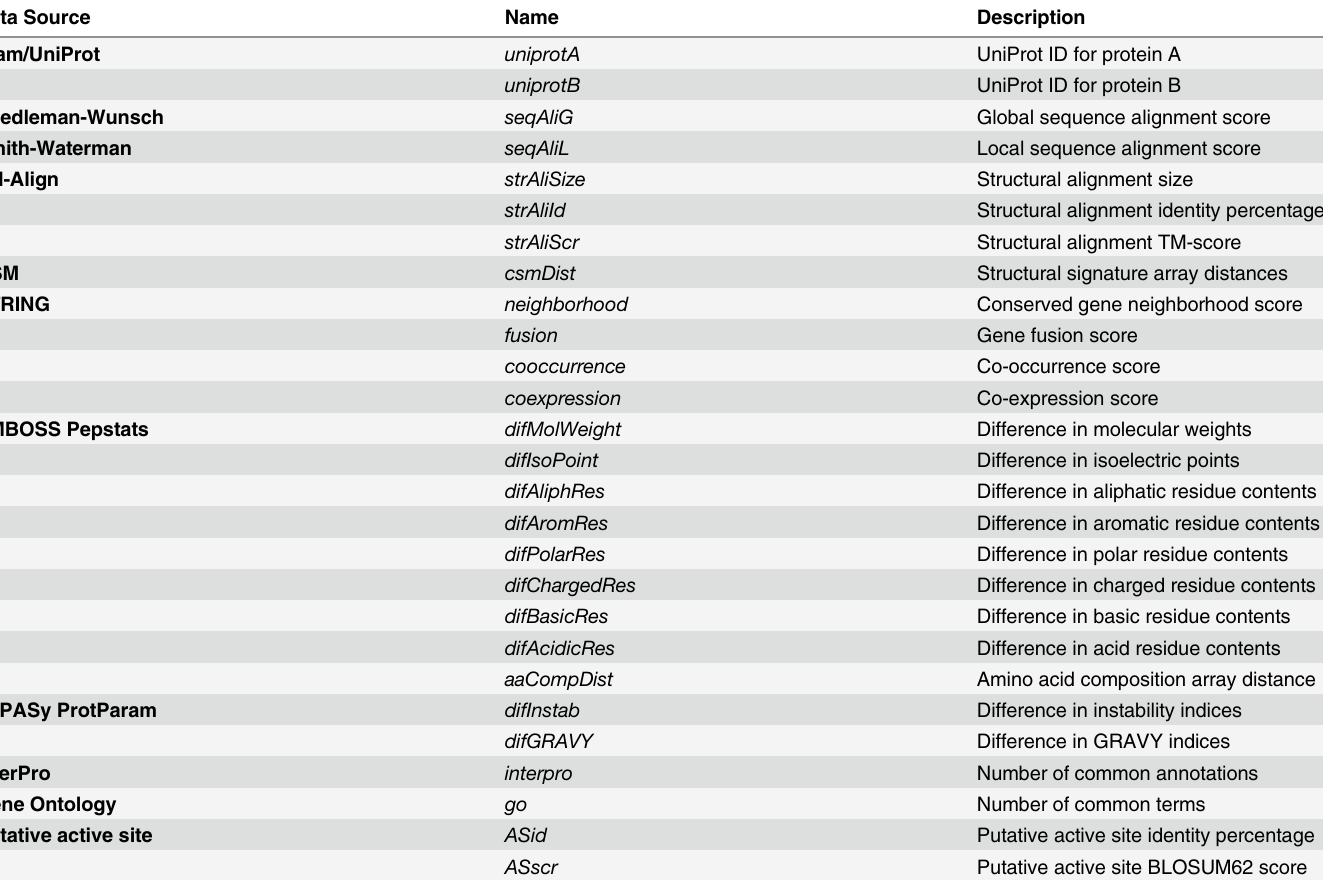
Table 1. Data sources and corresponding identifiers for the protein similarity matrices employed in this